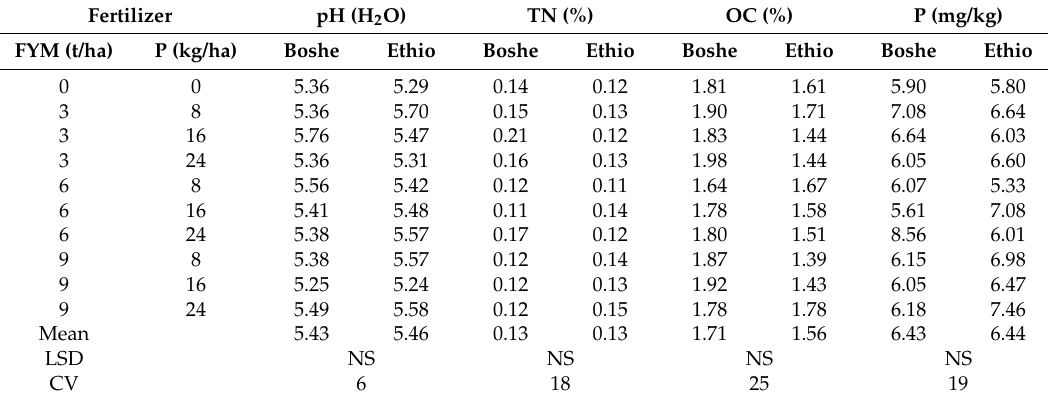
Table 4. Effects of soybean varieties, FYM and inorganic P fertilizer application on soil pH, organic carbon, total nitrogen and available phosphorus after soybean harvesting in the 2012 cropping season at Bako, Western Ethiopia.